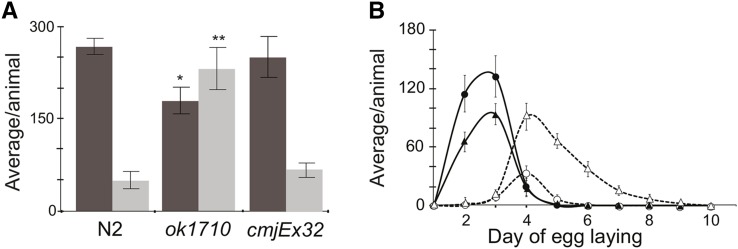
Brood size and unfertilized oocytes hlh-25(ok1710) animals. (A) hlh-25(ok1710) animals have fewer live progeny and lay more unfertilized eggs than wild-type animals. Expression of the extrachromosomal array cmjEx32, which carries hlh-25 genomic sequences, rescues this phenotype in hlh-25(ok1710) animals. Graph shows mean of total numbers of live progeny (dark bars) and unfertilized eggs (light bars) produced during the entire lifespans of wild-type (n = 7), hlh-25(ok1710) (n = 12), and hlh-25(ok1710; cmjEx32) animals (n = 9). *P-value < 0.05, **P-value < 0.005. (B) Average numbers of live progeny (solid lines) and unfertilized eggs (dashed lines) produced per day of egg laying by the same hlh-25(ok1710) animals (triangles) and wild-type animals (circles) as those shown in (A).